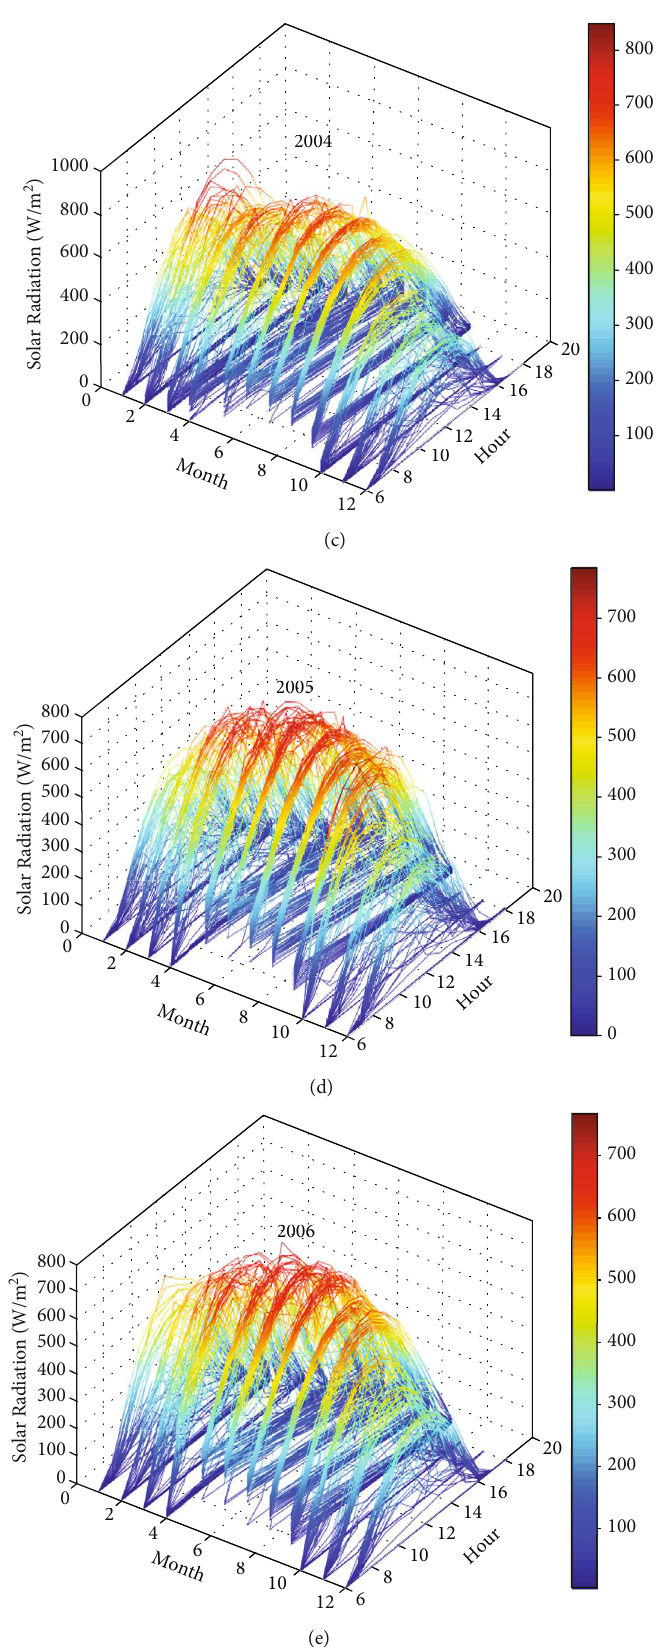
Figure 3: The 3D distribution plots of HAGSR of Isparta measured for the years (a) 2002, (b) 2003, (c) 2004, (d) 2005, and (e)